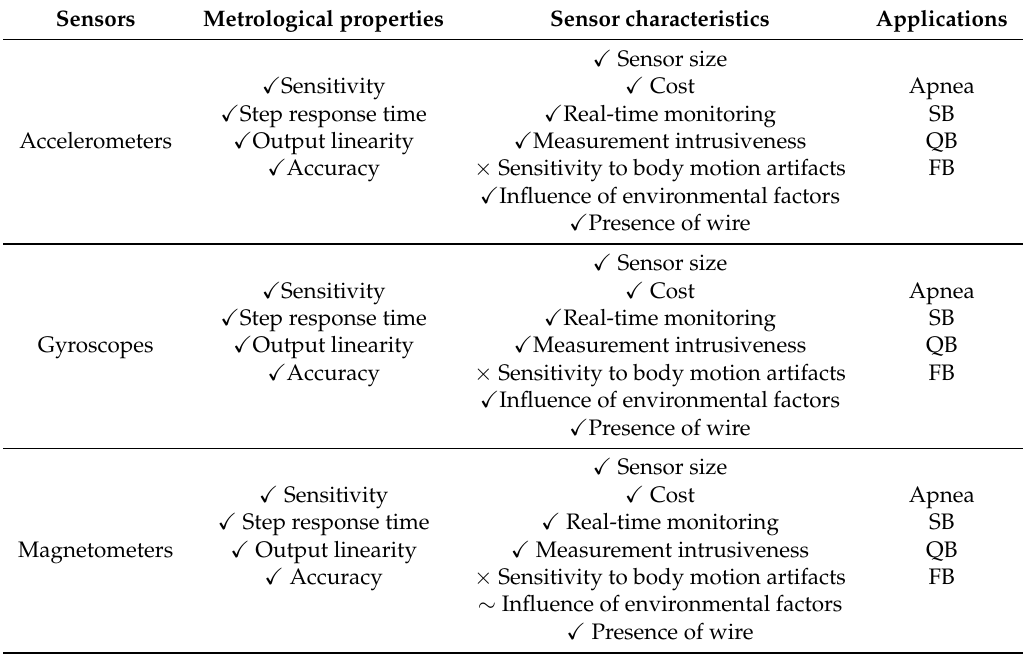
Table 8. Main metrological properties and characteristics of the movement sensors used for f R measurement. (cid:88) good to excellent, ∼ sufficient, ×